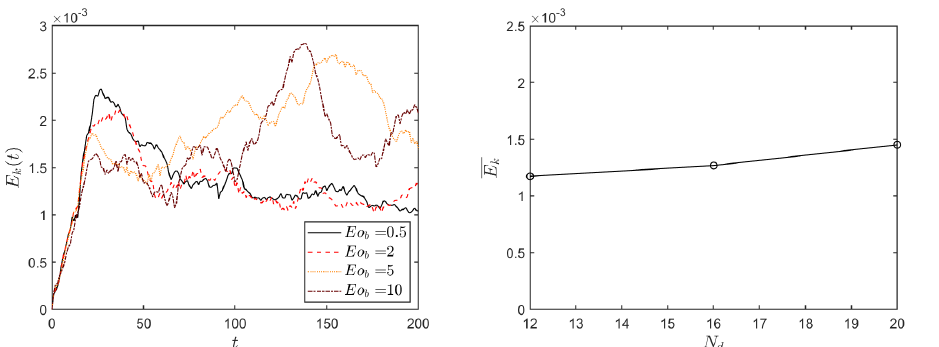
Figure 4. The kinetic energy in the liquid versus time for N d = 12 and several Eötvös numbers ( left ). The time-averaged kinetic energy versus N d for Eo b = 2 ( right